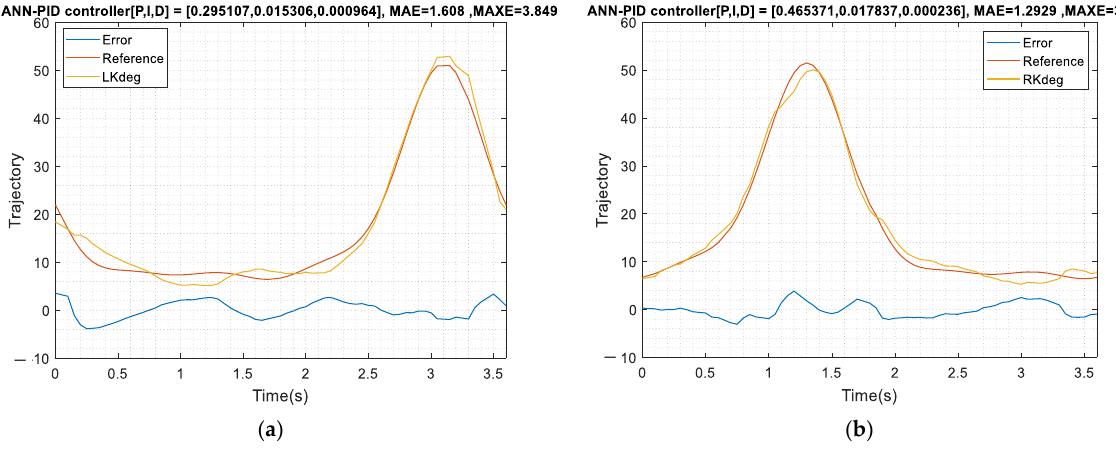
Figure 23. PID (PSO tuned)-ANN feedforward control loaded response. ( a ) Tracking result of left knee; ( b ) Tracking result of right knee.